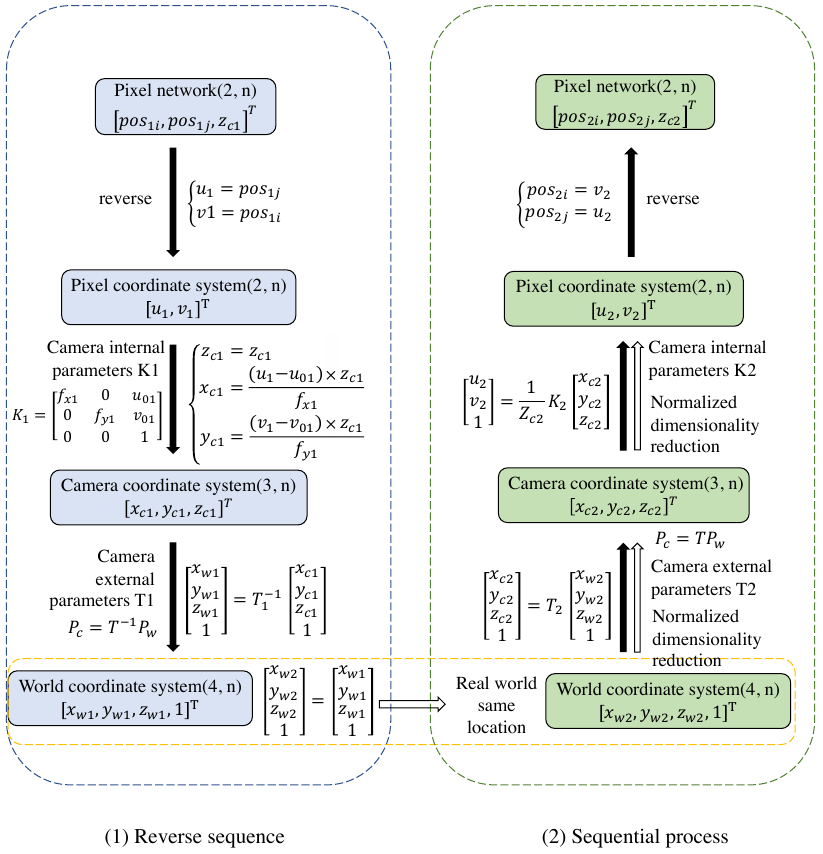
Figure 4.6.The coordinate point pair corresponding to the image pair generated by the coordinate system conversion relationship Figure 4. The coordinate point pair corresponds to the image pair generated by the coordinate system conversion relationship. (Here the subgraph (1) shows the reserve computation sequence of the coordinates while (2) shows the sequential